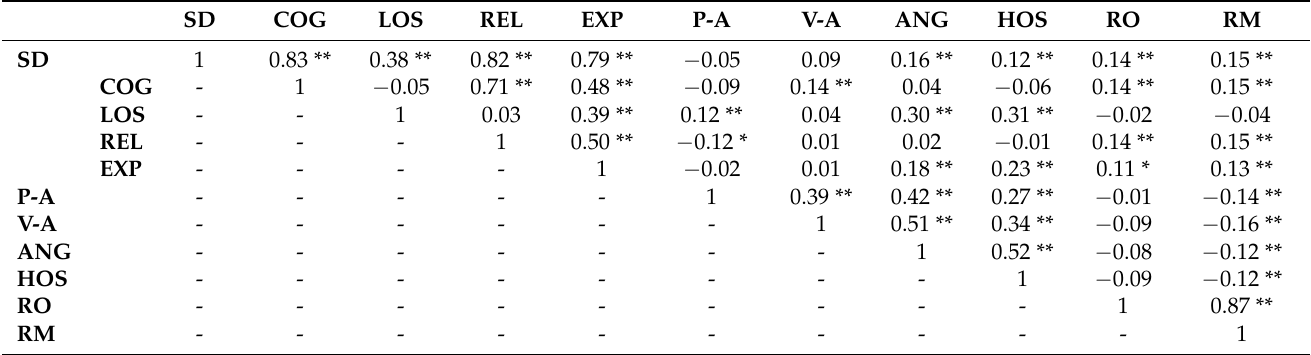
Table 3. Pearson’s r correlation results for all measured variables.